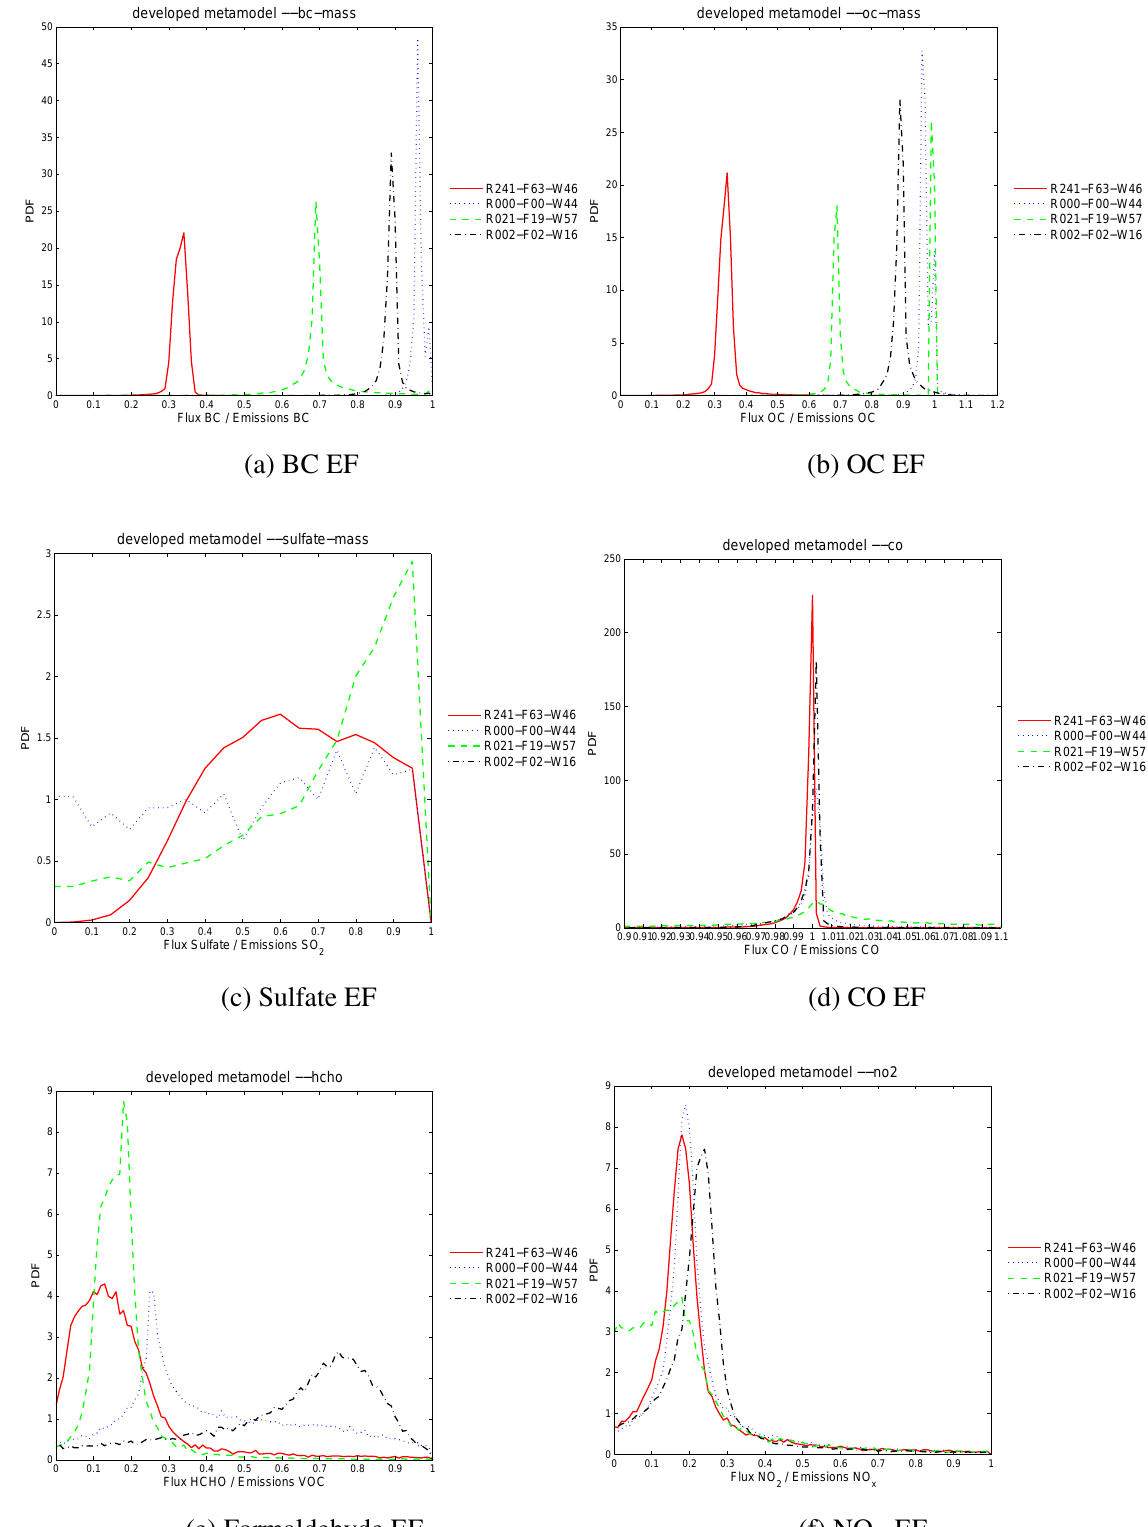
Fig. 10. These are the PDFs of the total urban area EFs (Eq. 8), from the Developed metamodel. For inputs, please refer to Fig. 5. Fig. 10: These are the PDFs of the total urban area EFs 8, from the Developed metamodel. For inputs, please refer to Figure 5 Atmos. Chem. Phys., 11, 7629–7656,